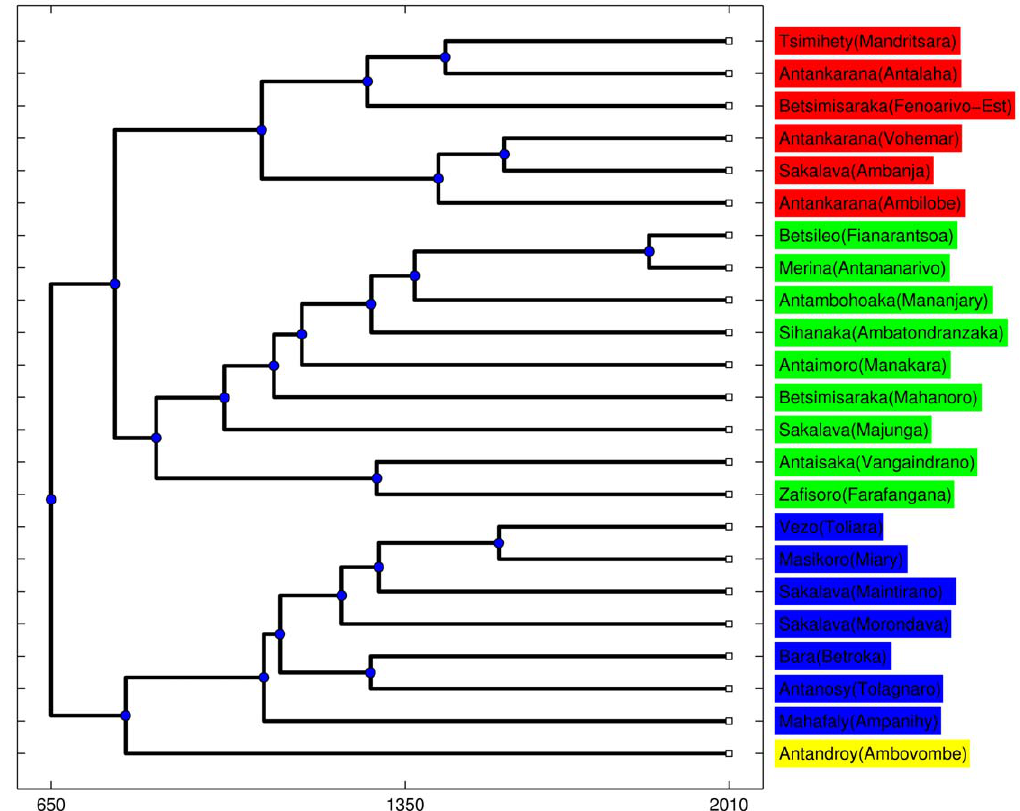
Figure 1. Phylogenetic tree of 23 Malagasy dialects realized by Unweighted Pair Group Method Average (UPGMA). In this figure the name of the dialect is followed by the name of the town where it was collected. The phylogenetic tree shows a main partition of the Malagasy dialects into four main groups associated with different colors. The strict correspondence of this cladogram with the geography can be appreciated by comparison with Fig. 2.